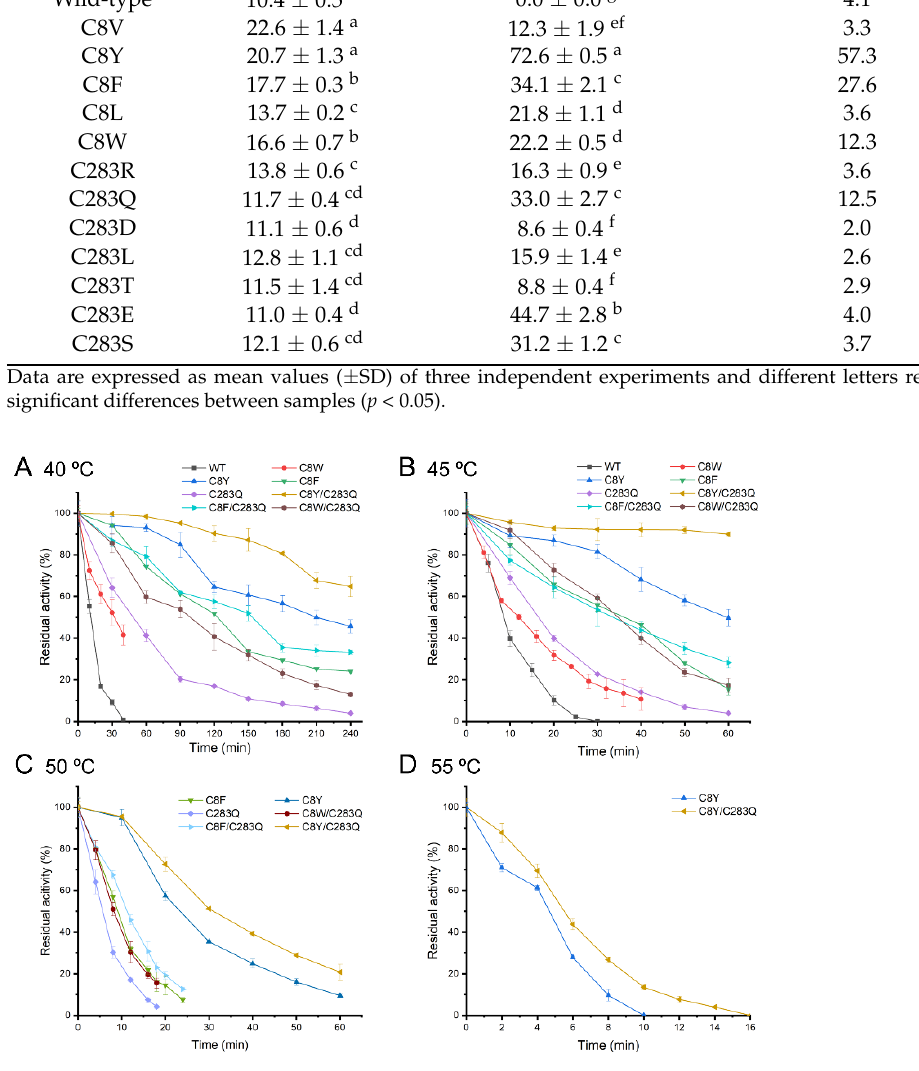
Figure 2. Thermostability of AsA wild-type and mutants under 40 °C ( A ), 45 °C ( B ), 50 °C ( C ), and 55 °C ( D ). Data are expressed as mean values (±SD) of three independent experiments.